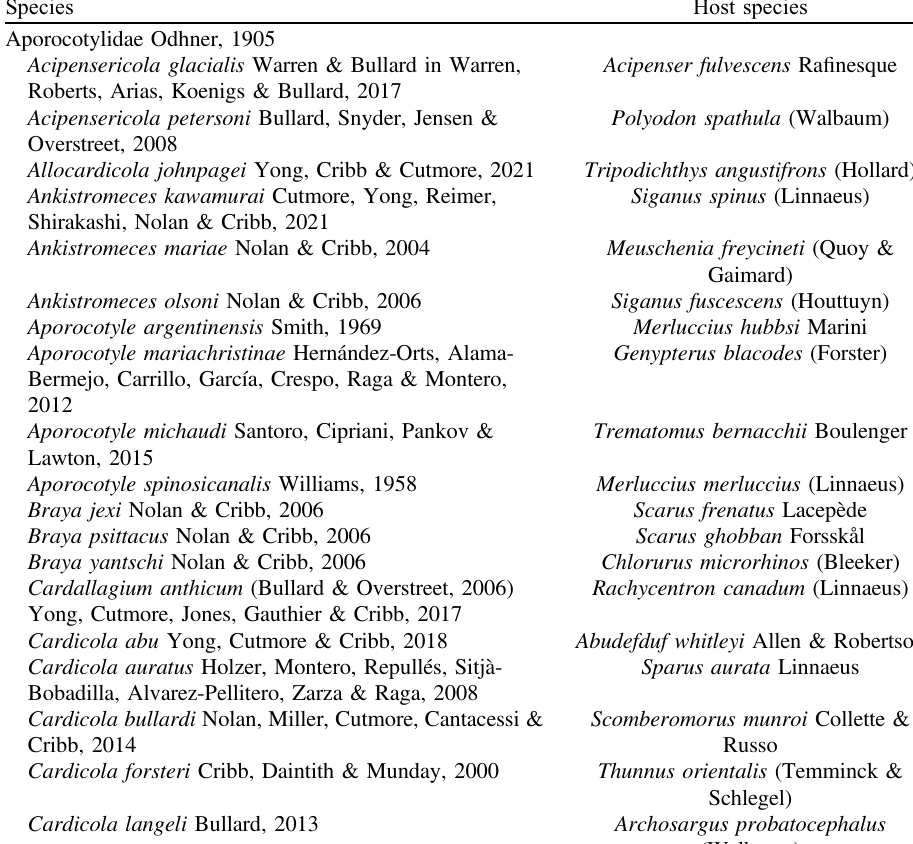
Table 1. Collection data and GenBank accession numbers for aporocotylid species incorporated in the 28S analyses.